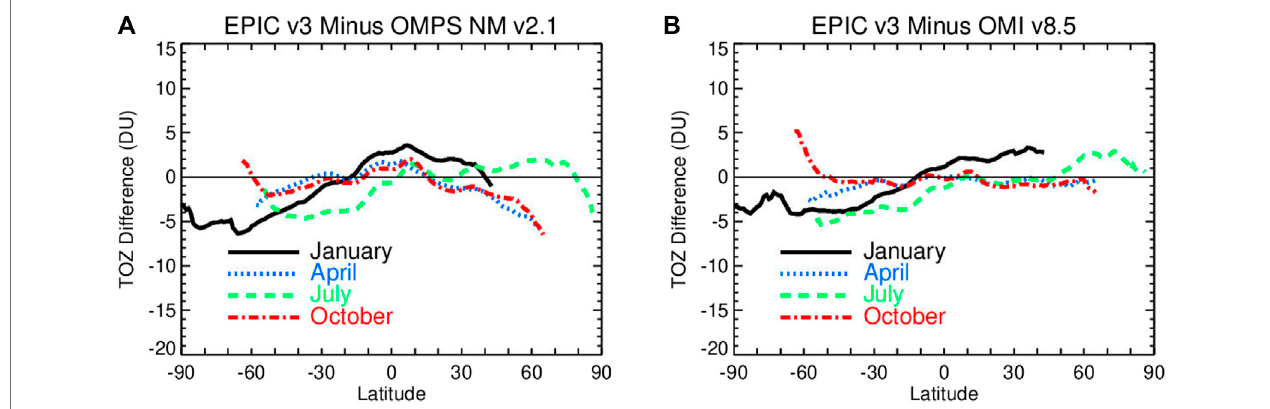
FIGURE6| Meanbiases inTOZbetweenEPIC v3andOMPSNMv2.1 (A) and EPICv3and OMIv8.5 (B) inDU.Biasesareshownfor4 months(shown indifferent colors)andcalculatedoverperiodfromJune2015toDecember2020.OnlyEPICretrievalswiththealgorithm fl agequalto1,or101,or111andSZAandSLA < 70 ° were used in these